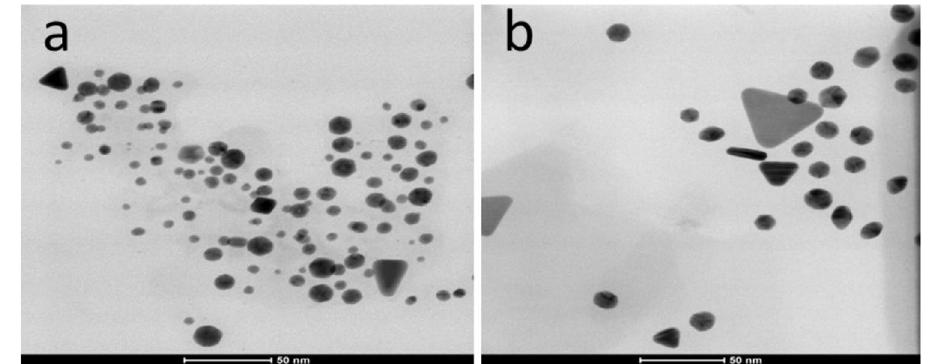
Figure 4. TEM images of ( a ) AuNP dichloromethane and ( b ) AuNP hexane showing the different